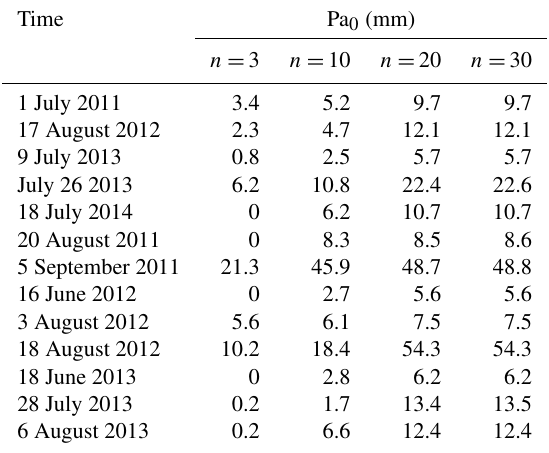
Table 6. The comparisons of P a0 when n have different values.